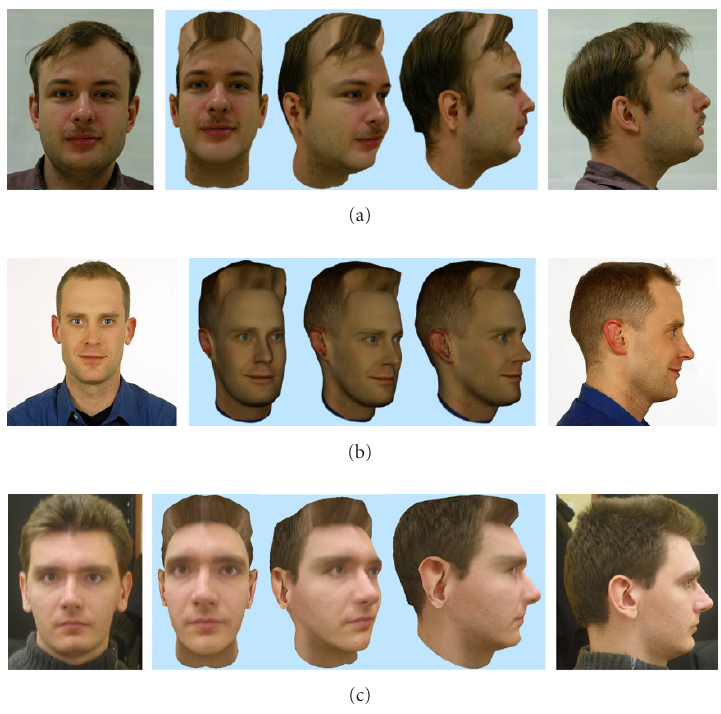
Figure 24: Final face models (Western men) generated by the proposed system.